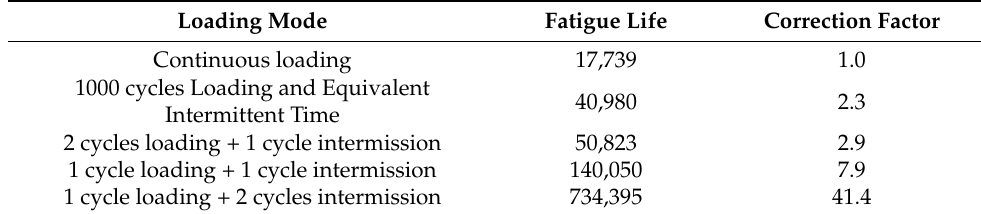
Table 12. Fatigue Correction Coefficient of GSP [117,118].